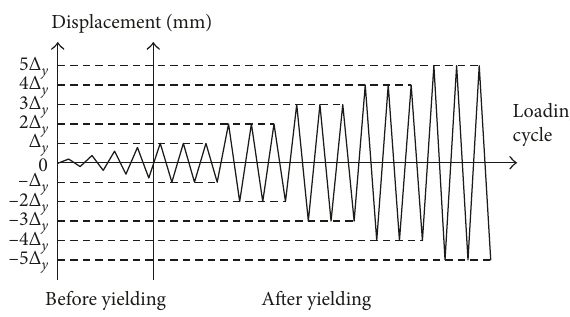
Figure 4: The diagram of the loading process.